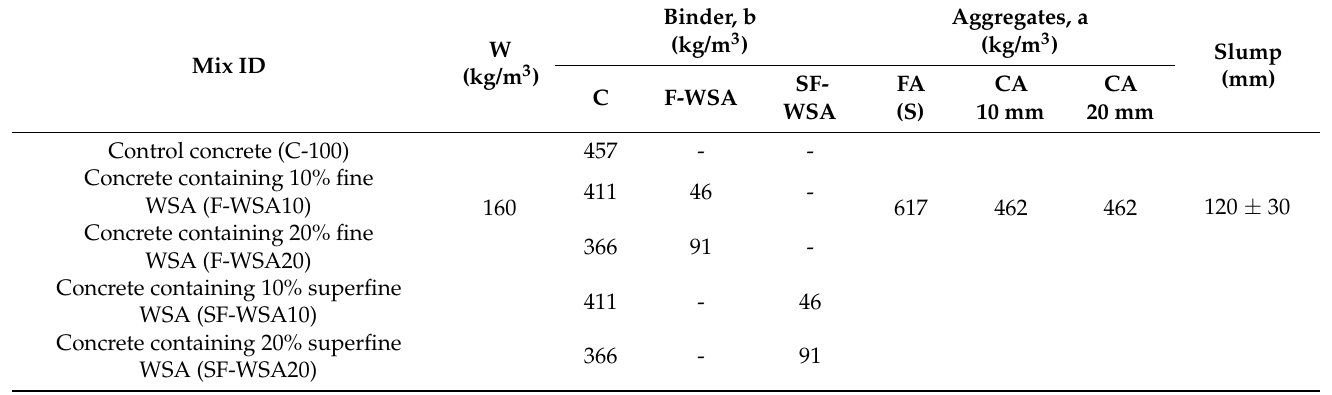
Table 3. Mixture proportions of concrete samples for compressive and tensile tests, and autogenous